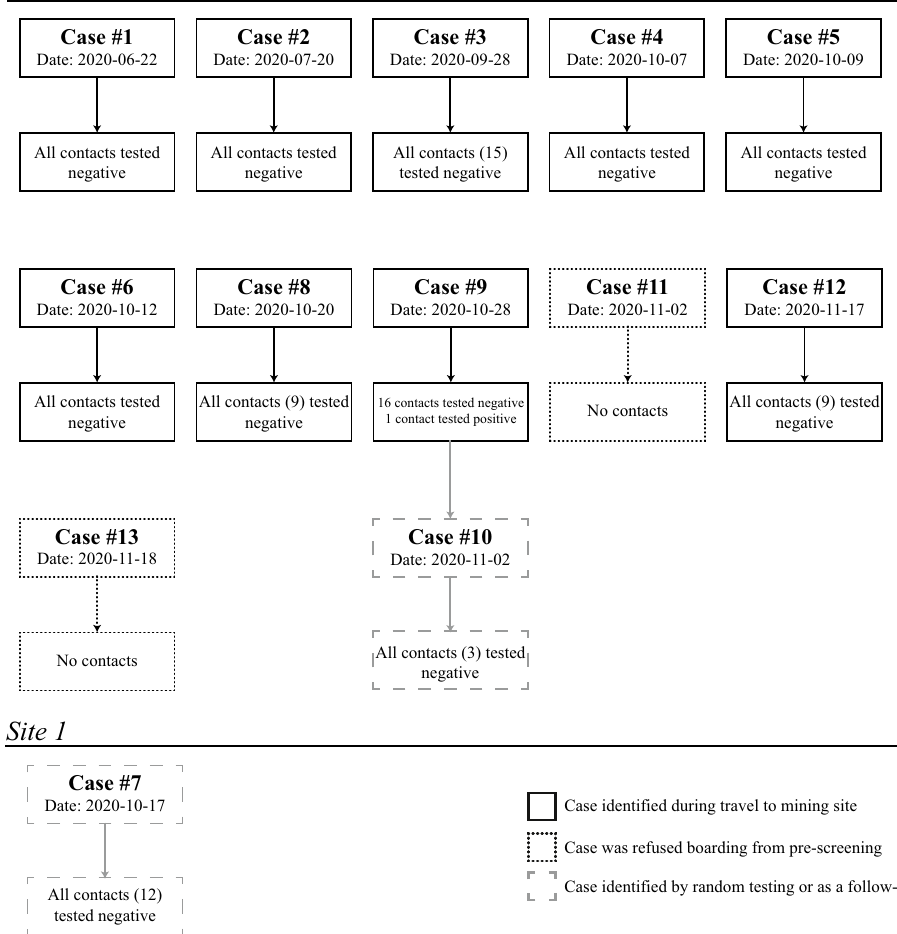
Figure 1. Individuals were infected with SARS-CoV-2, as identified by RT-PCR at the airport or Site A laboratory. In total, 13 individuals were identified as positive for SARS-CoV-2. Of those, 11 were identified at the airport’s laboratory, while 2 were identified at the laboratory established at Site A. Of the 11 travelers identified, one was intended for an international business trip (Case #1), two were traveling to Site B (Case #2 and #3), while the other eight individuals were either symptomatic and refused boarding, or they were scheduled to head to Site A (Case #4, #5, #6, #8, #9, #11, #12, and #13). For the remaining two cases, one was identified